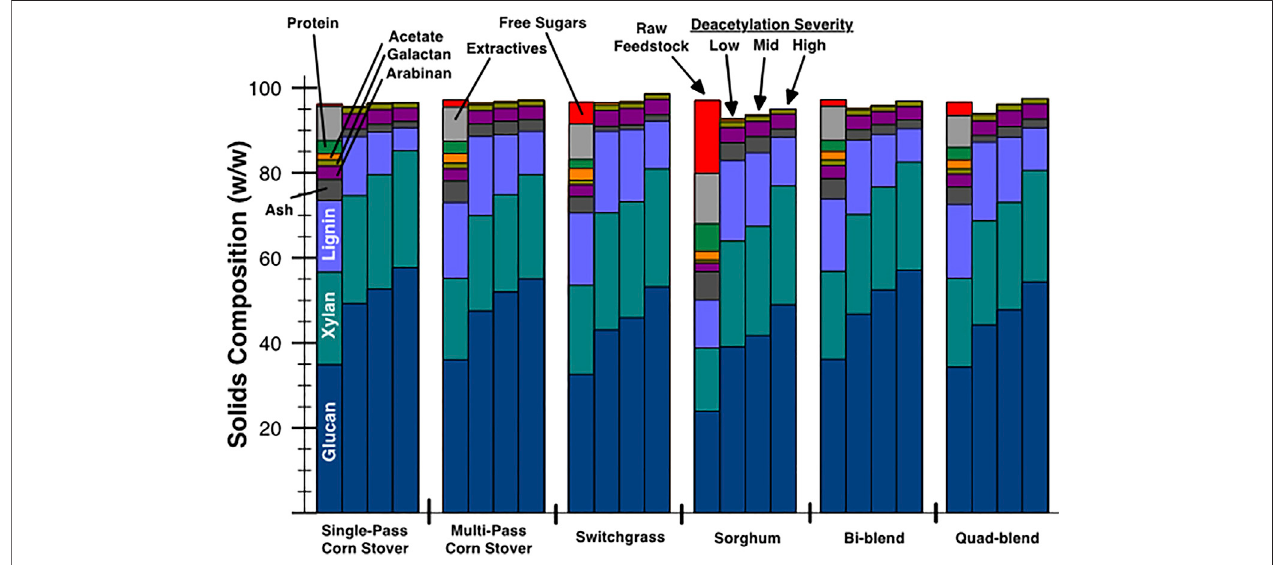
FIGURE 3 | Raw and deacetylated feedstock solids composition by component. The left bar in each cluster is the raw feedstock, and the remaining three bars to the right are low severity (50 kg NaOH/MT biomass) at 80 ° C, mid severity (70 kg NaOH/MT biomass) at 92 ° C, and high severity (100 kg NaOH/MT biomass) at 92 ° C severity deacetylation,